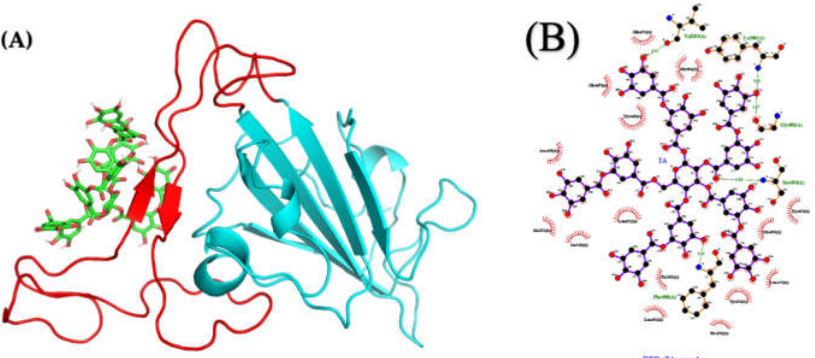
Figure 9. Molecular structures after 1000 ns of MD: ( A ) TA/RBD complex (pose 1; molecular me-